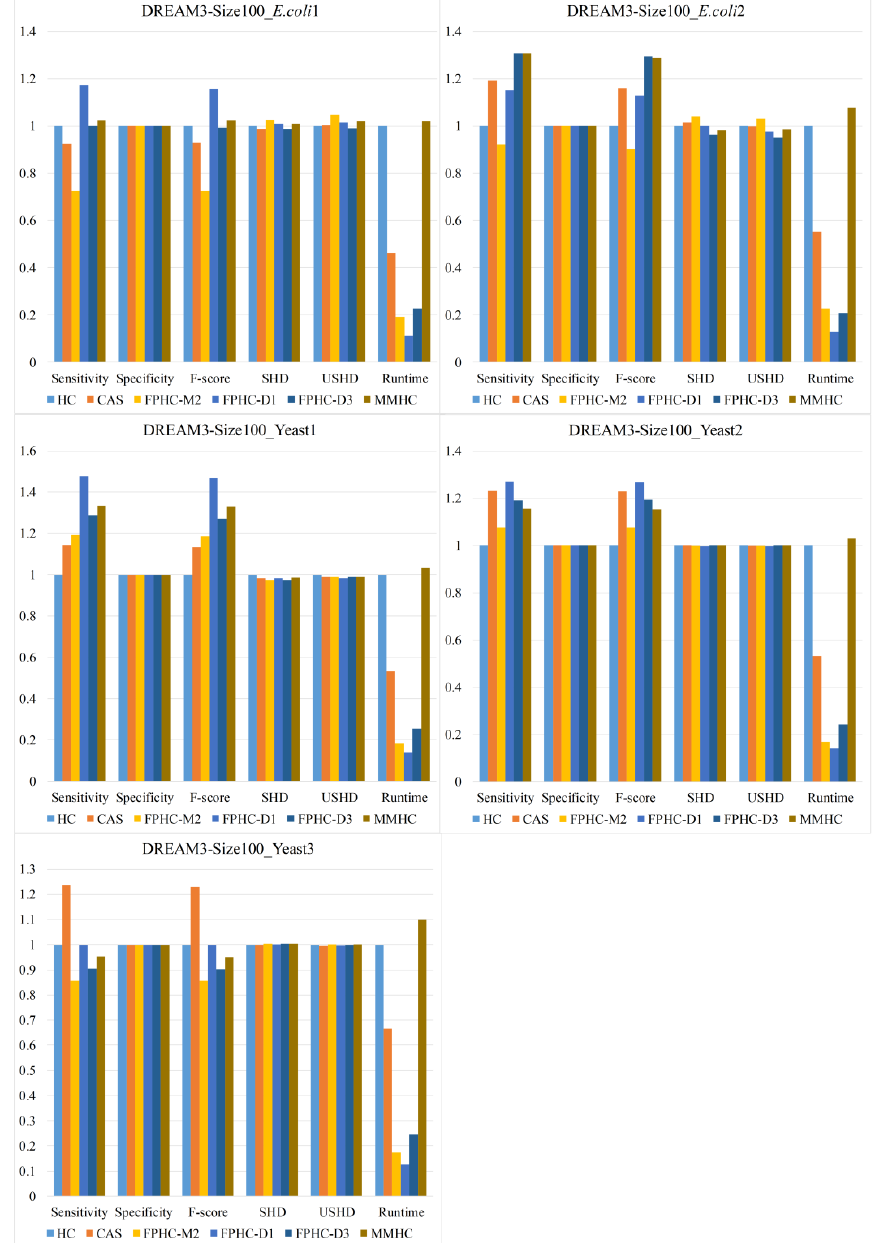
Figure 8. The comparison results on the DREAM networks.